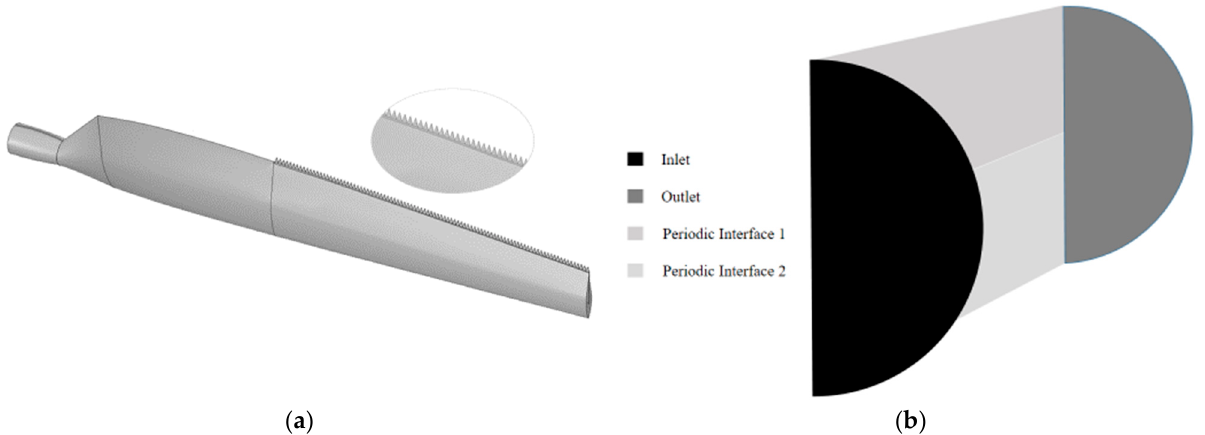
Figure 4. NREL phase VI modified blade with trailing edge serrations ( a ) and computational domain ( b ).